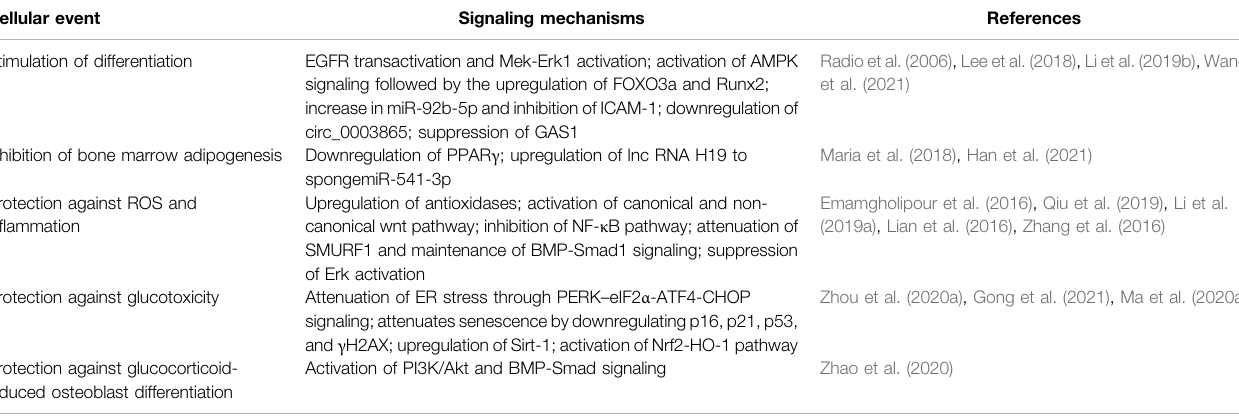
TABLE 1 | Osteogenic pathways and molecular